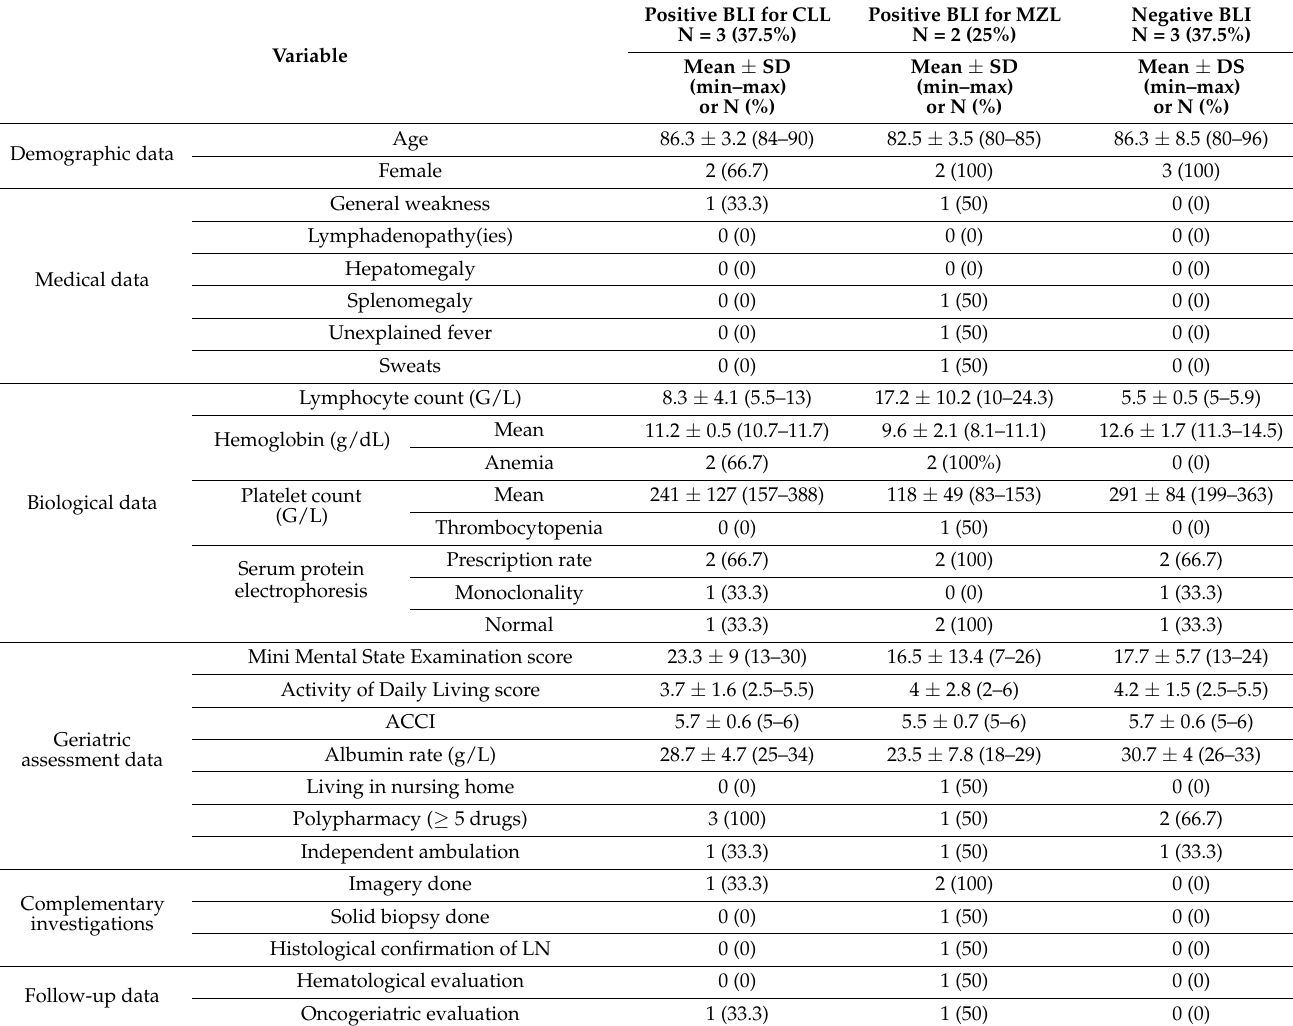
Table 1. Characteristics of patients in the lymphocytosis group